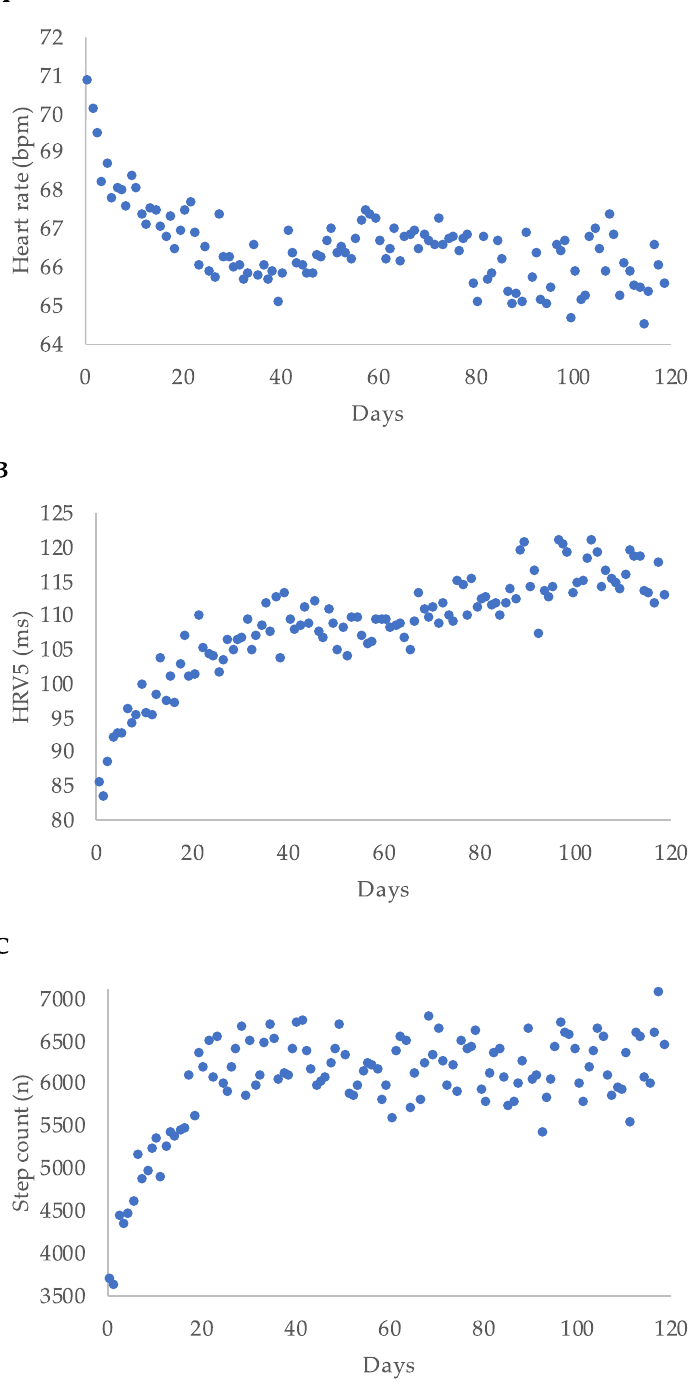
Figure 3. Heart rate ( A ), heart rate variability approximate (HRV5) ( B ), and step count ( C ) displayed as median per day for the first 120 days of wear time for all patients; bpm = beats per minute.